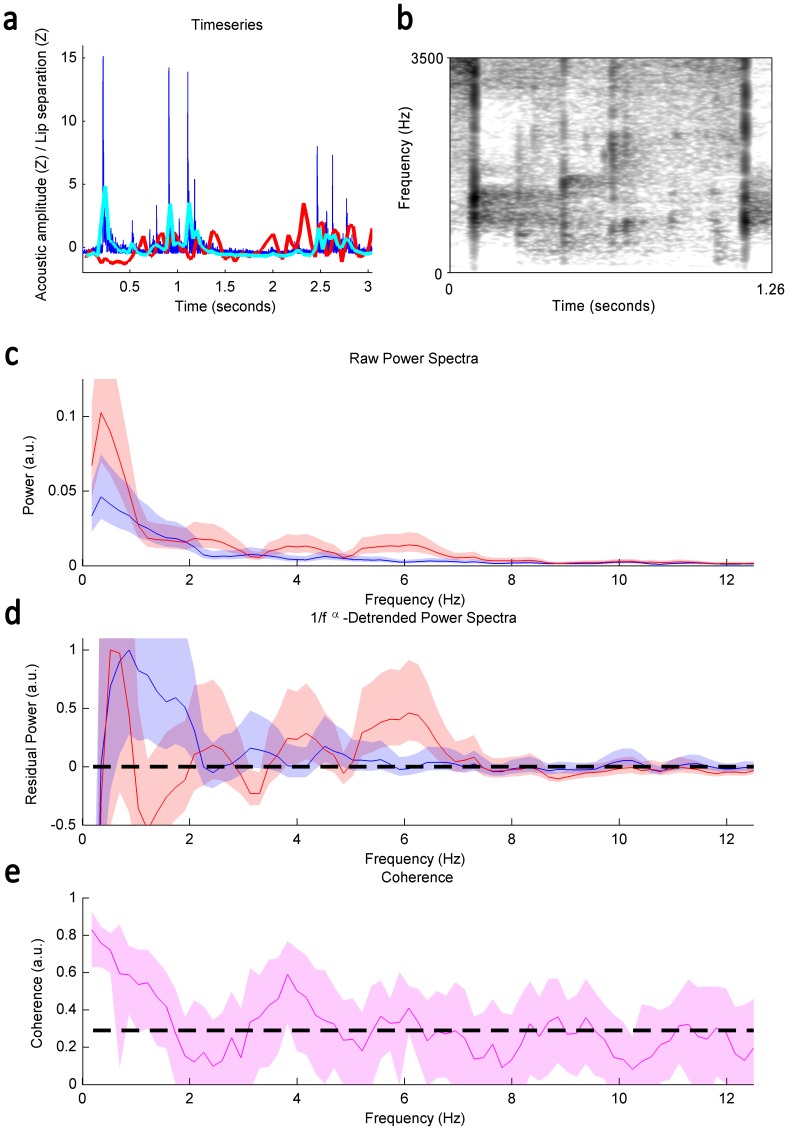
Descriptive analyses of orangutan clicks; a) Time series of an orangutan click bout.Dark blue line indicates raw power spectra (dB), light blue line indicates acoustic amplitude envelop measure, and red line indicates inter-lip distance measure. b) Spectrographic representation; c) Average estimates of raw power spectra; d) Detrended power spectra; e) Coherence of orangutan clicks.